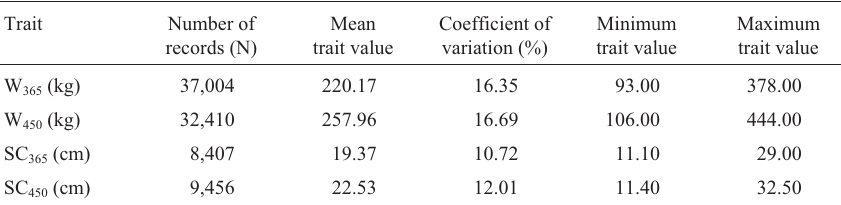
Table 1 - Descriptive statistics for all variables included in the analyses. Trait Number of records (N)